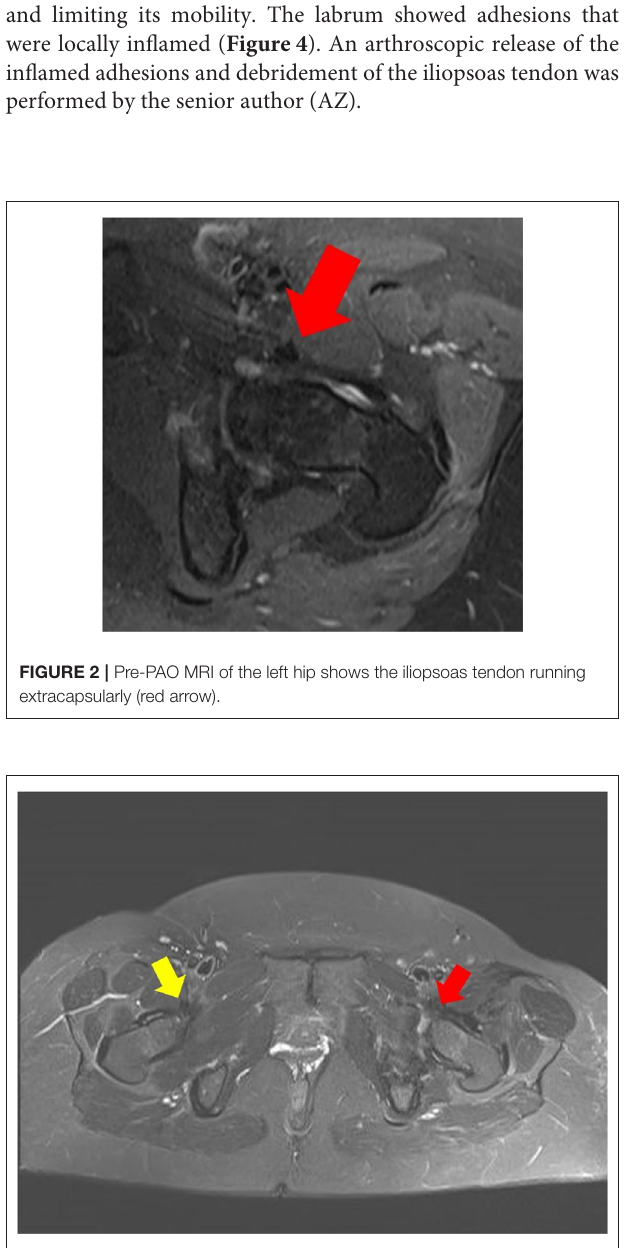
FIGURE 3 | Follow-up MRI after minimal invasive PAO with anteversion of the acetabulum showing normal anatomy of the right psoas tendon (yellow arrow) and intraarticular position of the left iliopsoas tendon (red